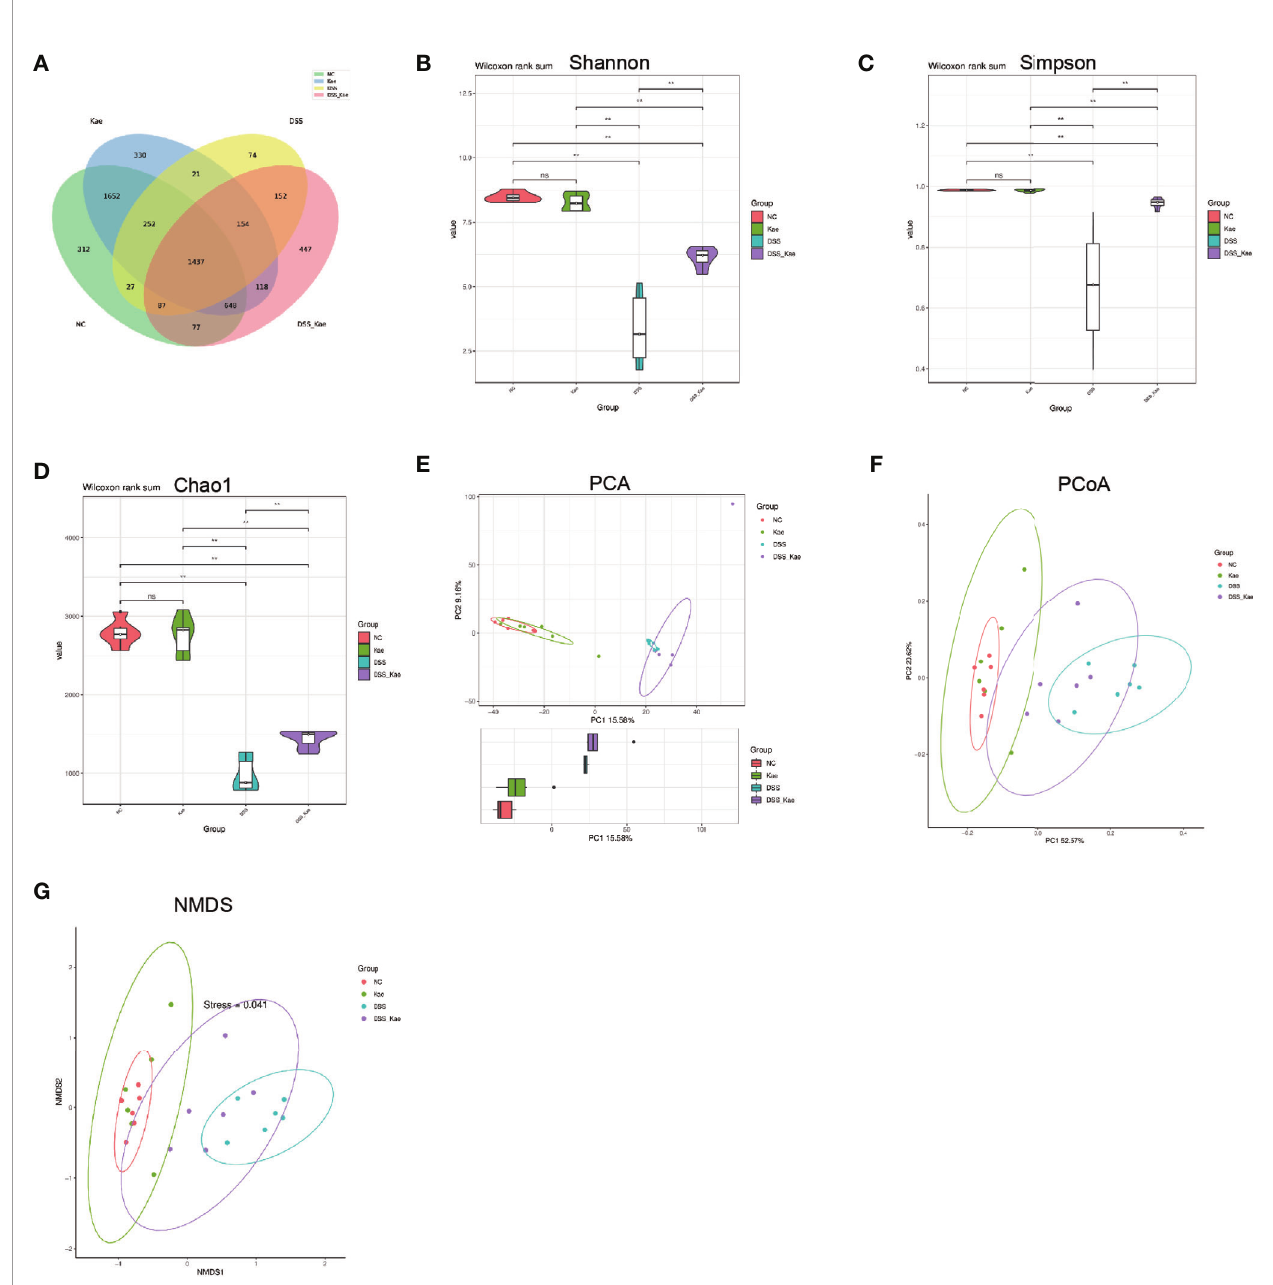
FIGURE 4 | Kae increased the diversity and richness of gut microbiota in DSS-induced mice. (A) Venn diagram illustrates the numbers of OTUs in the NC, Kae, DSS, and DSS-Kae groups. Alpha diversity is illustrated using a violin plot of the (B) Shannon, (C) Simpson, and (D) Chao indices. Beta-diversity was assessed using (E) PCA, (F) PCoA, and (G) NMDS, based on weighted UniFrac distances. Pairwise comparisons using the Wilcoxon rank sum test for alpha diversity, n = 6, ** P < 0.01; ns, no signi fi cant